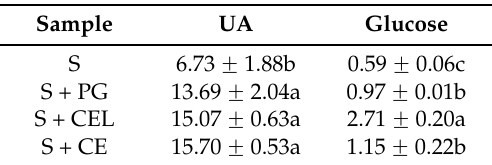
Table 3. Content of uronic acids and total glucose ( mg / g CW) in the supernatants obtained after the interaction of CWs with enzymes, in absence of